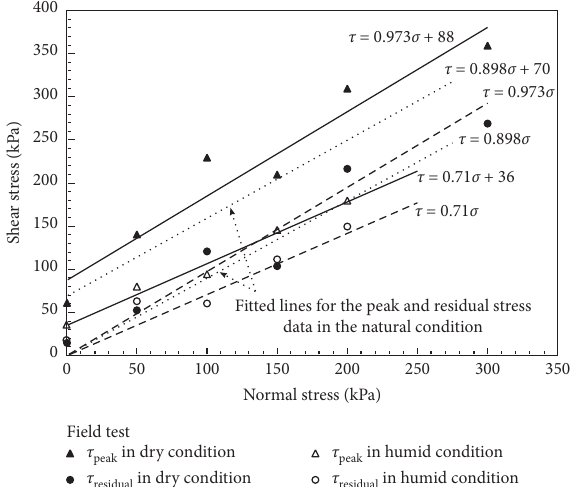
Figure 8: Test data and fitted lines of the in situ tests.